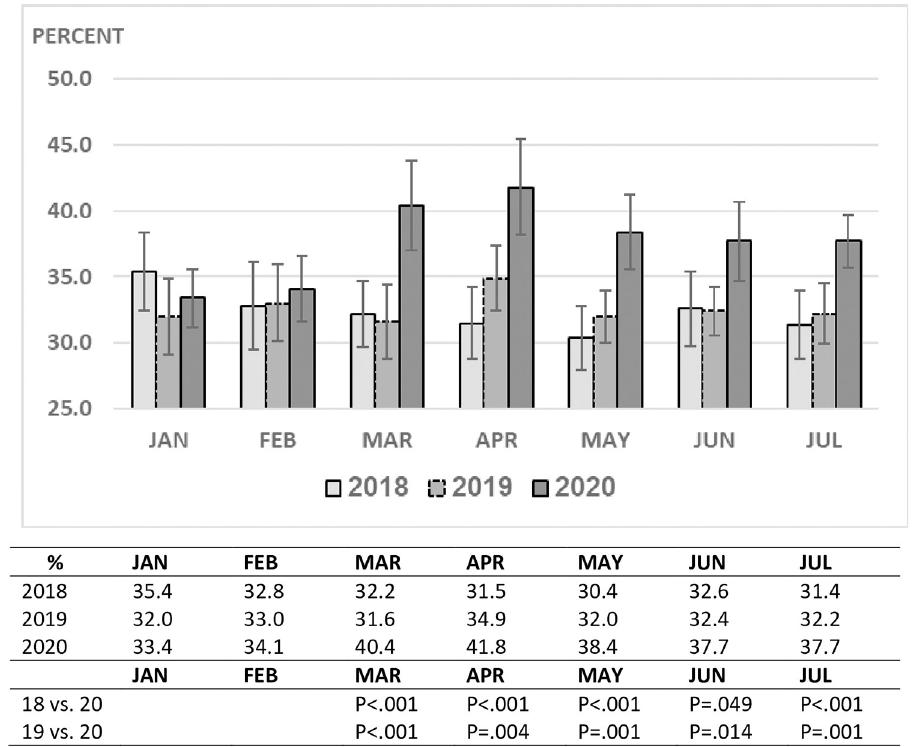
Fig 6. Adult ED hospitalization rate (%) by month and year.